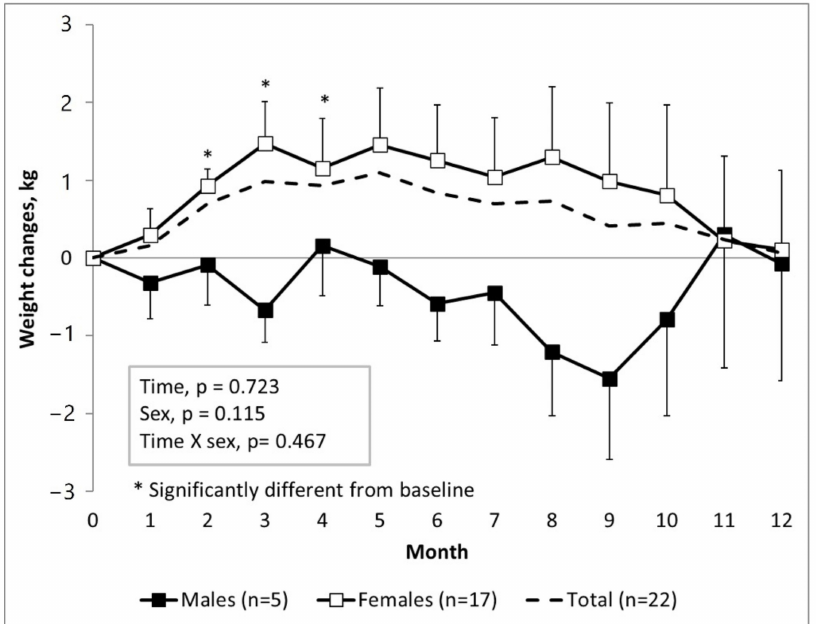
Figure 2. Different trajectories of monthly body weight change between male ( n = 5) and female ( n = 17) students during their first year at university. Female students are at risk for weight gain during the first few months, as compared to their male counterparts. Time effects, sex effects, and time x sex effects were analysed using GLM repeated measures ANOVA. * Significantly different from baseline, paired-sample t-tests, p < 0.05.